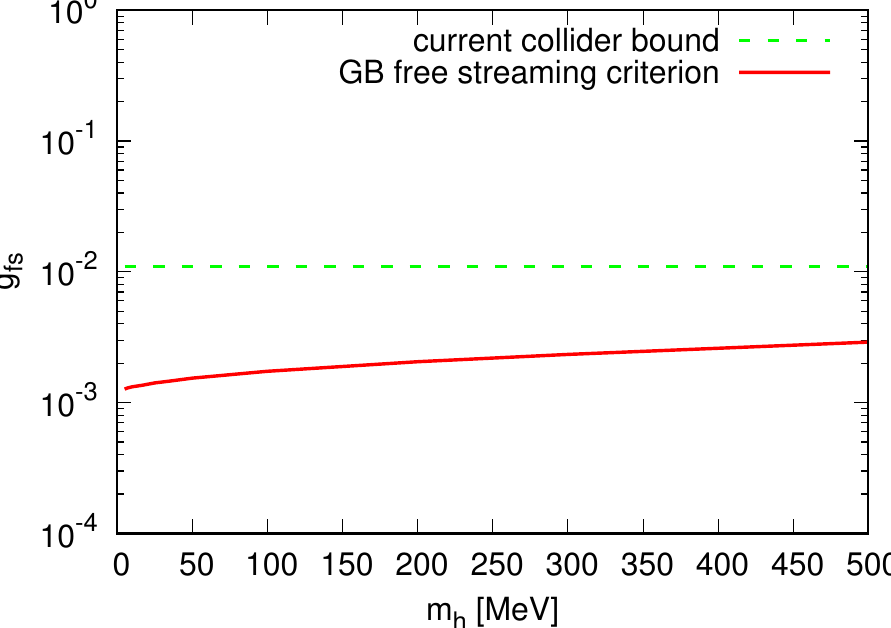
Figure 8 . Upper limits on the Higgs portal coupling g for Goldstone boson free-streaming out of the proto-neutron star core, eq. (4.12), for various light Higgs boson mass m h (solid). Also shown is the current collider bound, eq. (2.9)